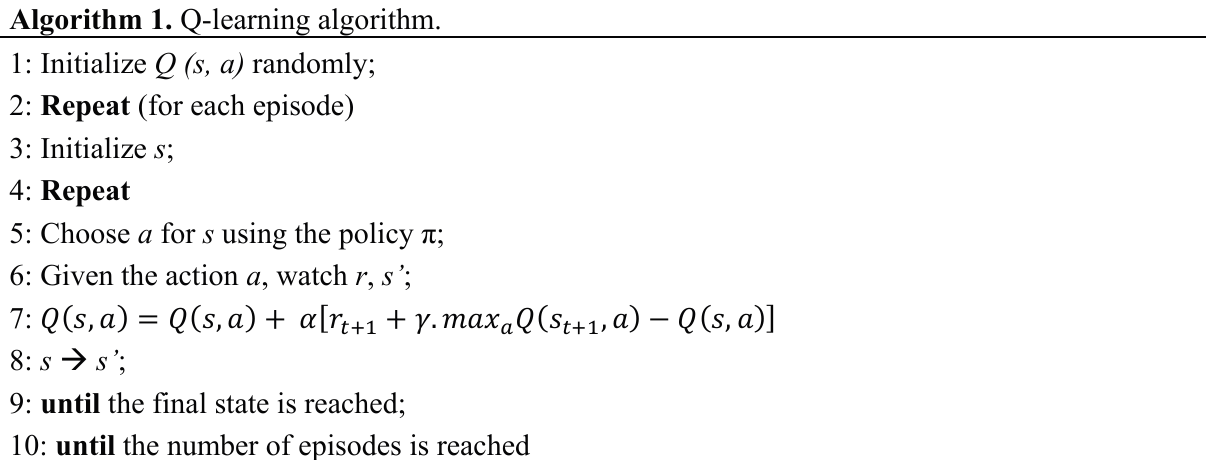
Algorithm 1. Q-learning